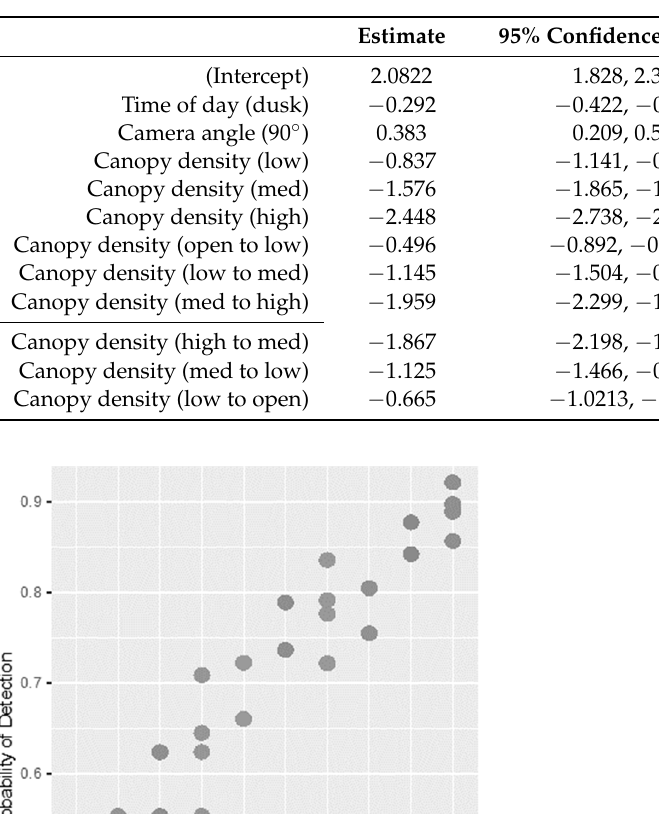
Table 2. The model with the best fit to the data for TIR images with manual detection includes time of day, camera angle, and canopy density.